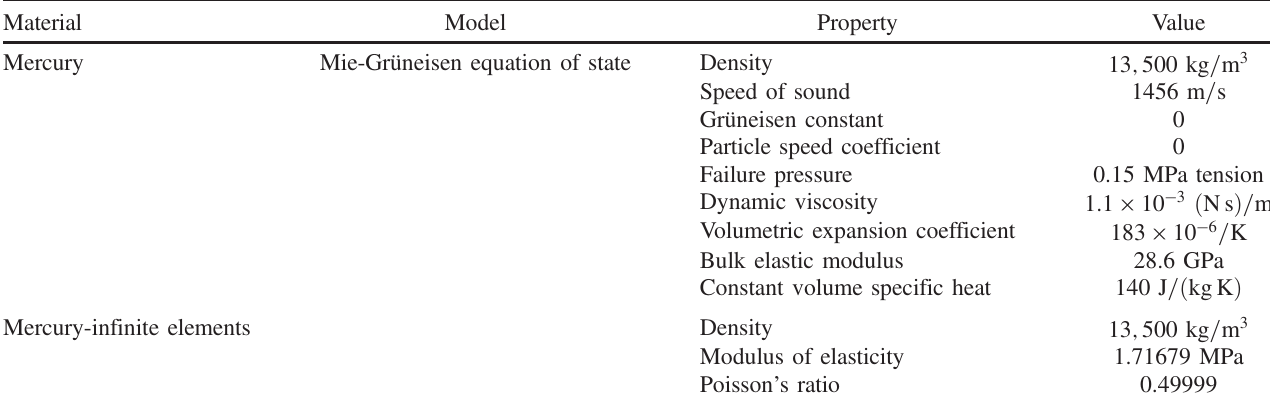
TABLE I. Mercury properties for pulse analyses. Material